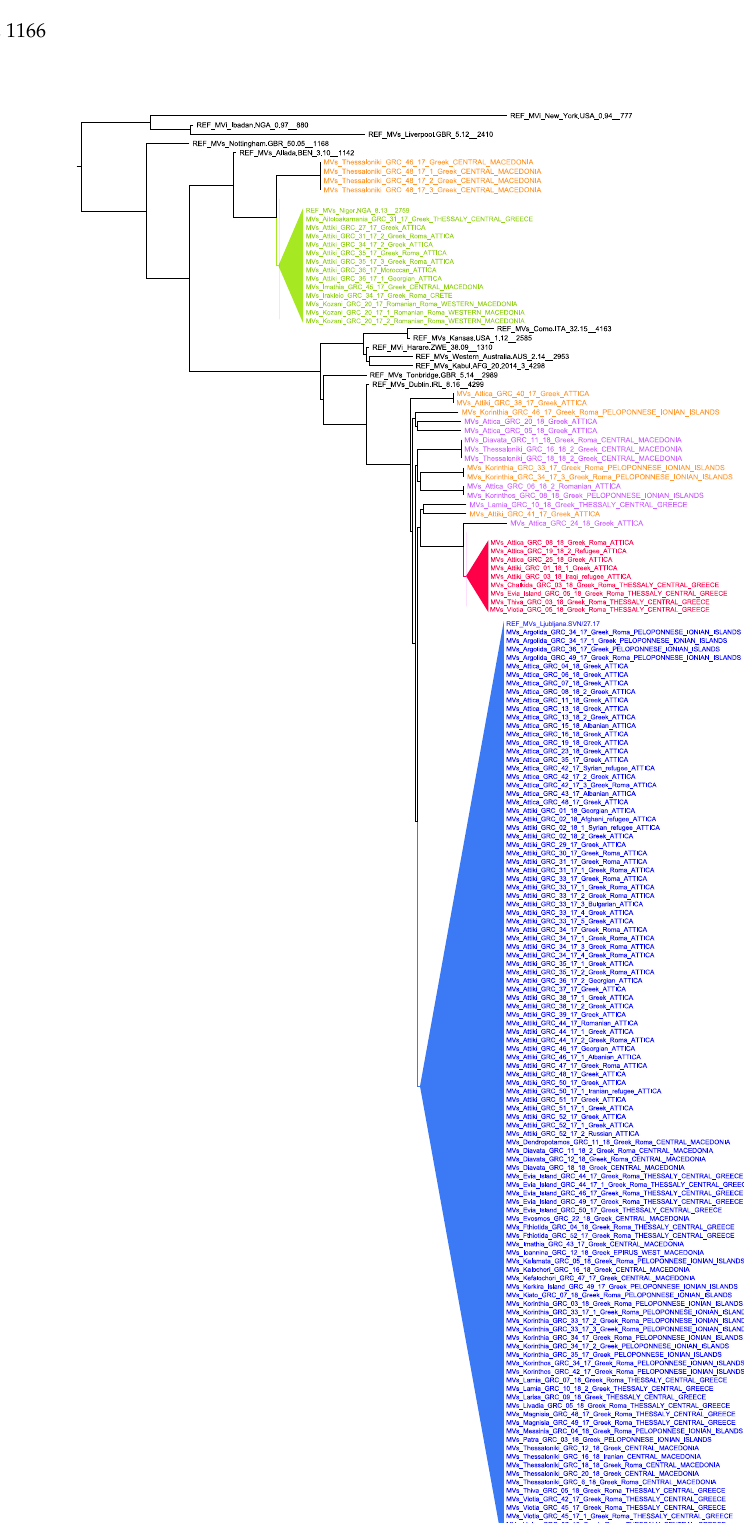
0.003 Figure 1. Evolutionary relationships of measles viruses circulating in Greece with other European and named strains from measles nucleotide surveillance (MeaNS) database and WHO reference strains for genotype B3, based on the 450 nucleotides sequence encoding the 150 carboxy-terminal amino acids of the N protein (N450). Three main circulating clusters are indicated in green, red and blue triangles. Lineages sampled in 2017 and 2018 and cocirculated with the main clusters are colored in orange and purple,